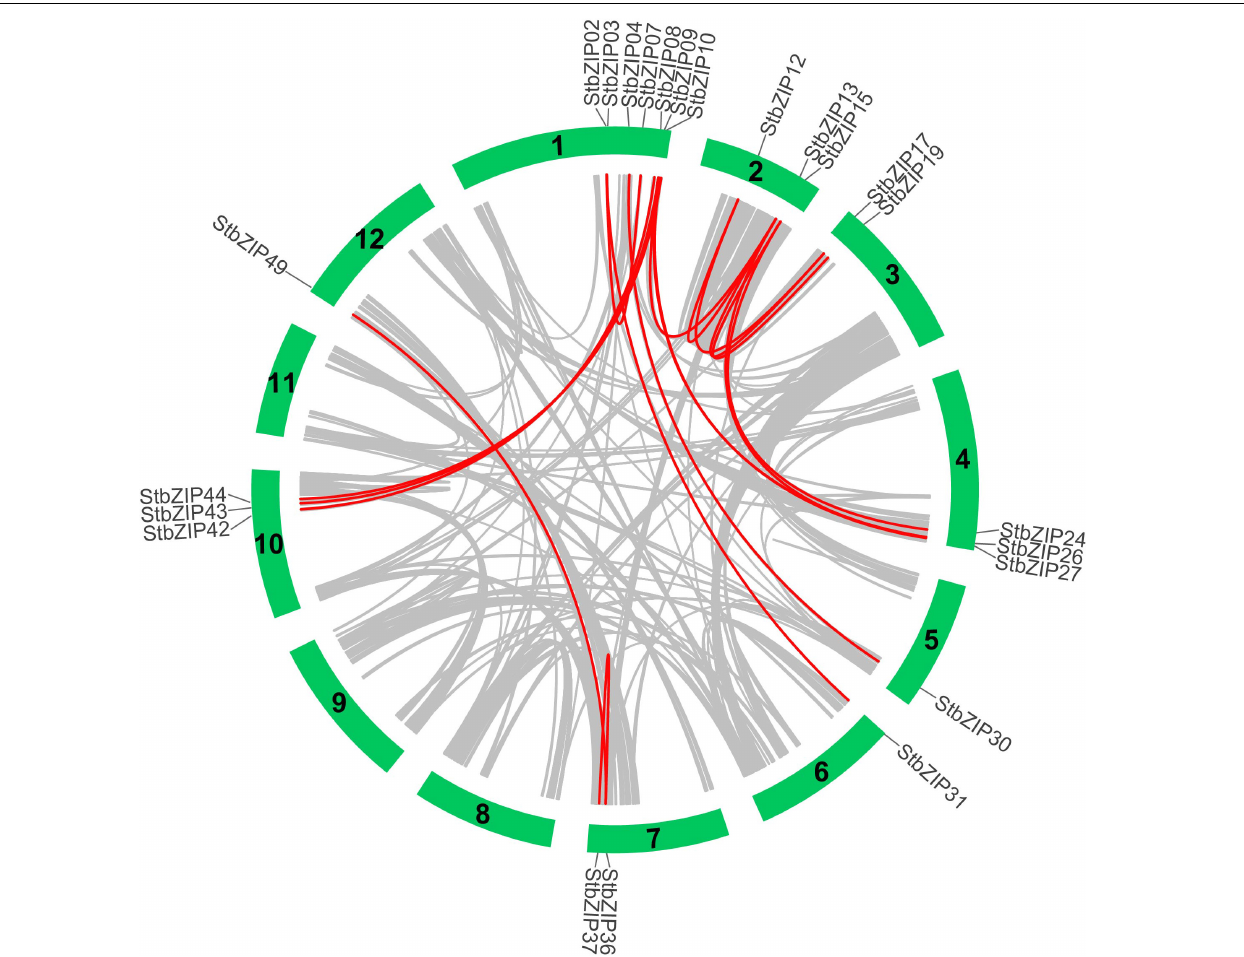
FIGURE 4 | Segmental duplication events and interchromosomal relationships between StbZIP genes. The 31 putative segmental duplication pairs of StbZIP genes were investigated with MCScanX and linked by the colored lines, respectively. The gray lines indicate all putative segmental duplication pairs in the potato genome, while the StbZIP segmental duplication pairs are linked by the red